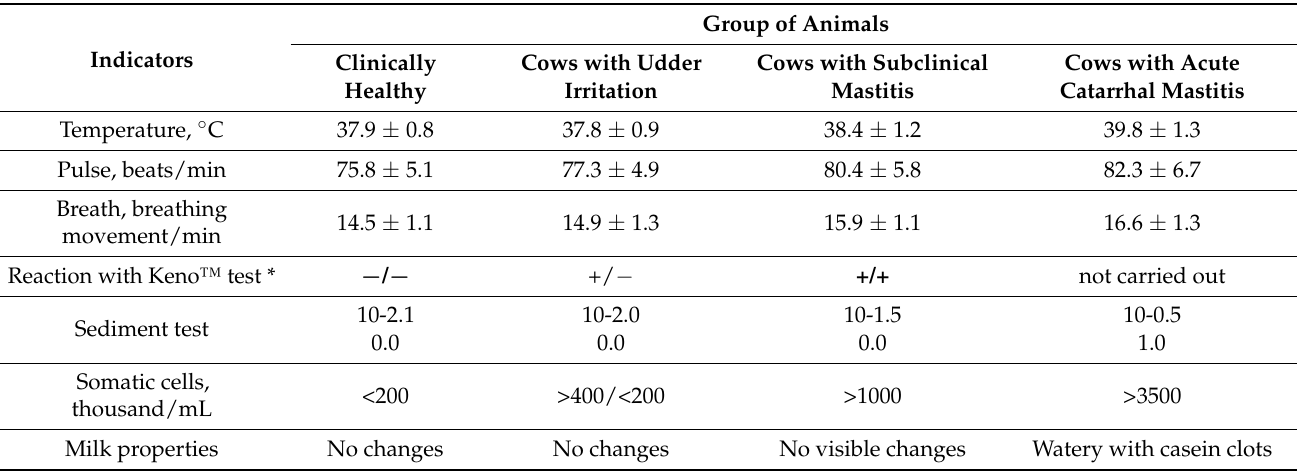
Table 2. Clinical observations of